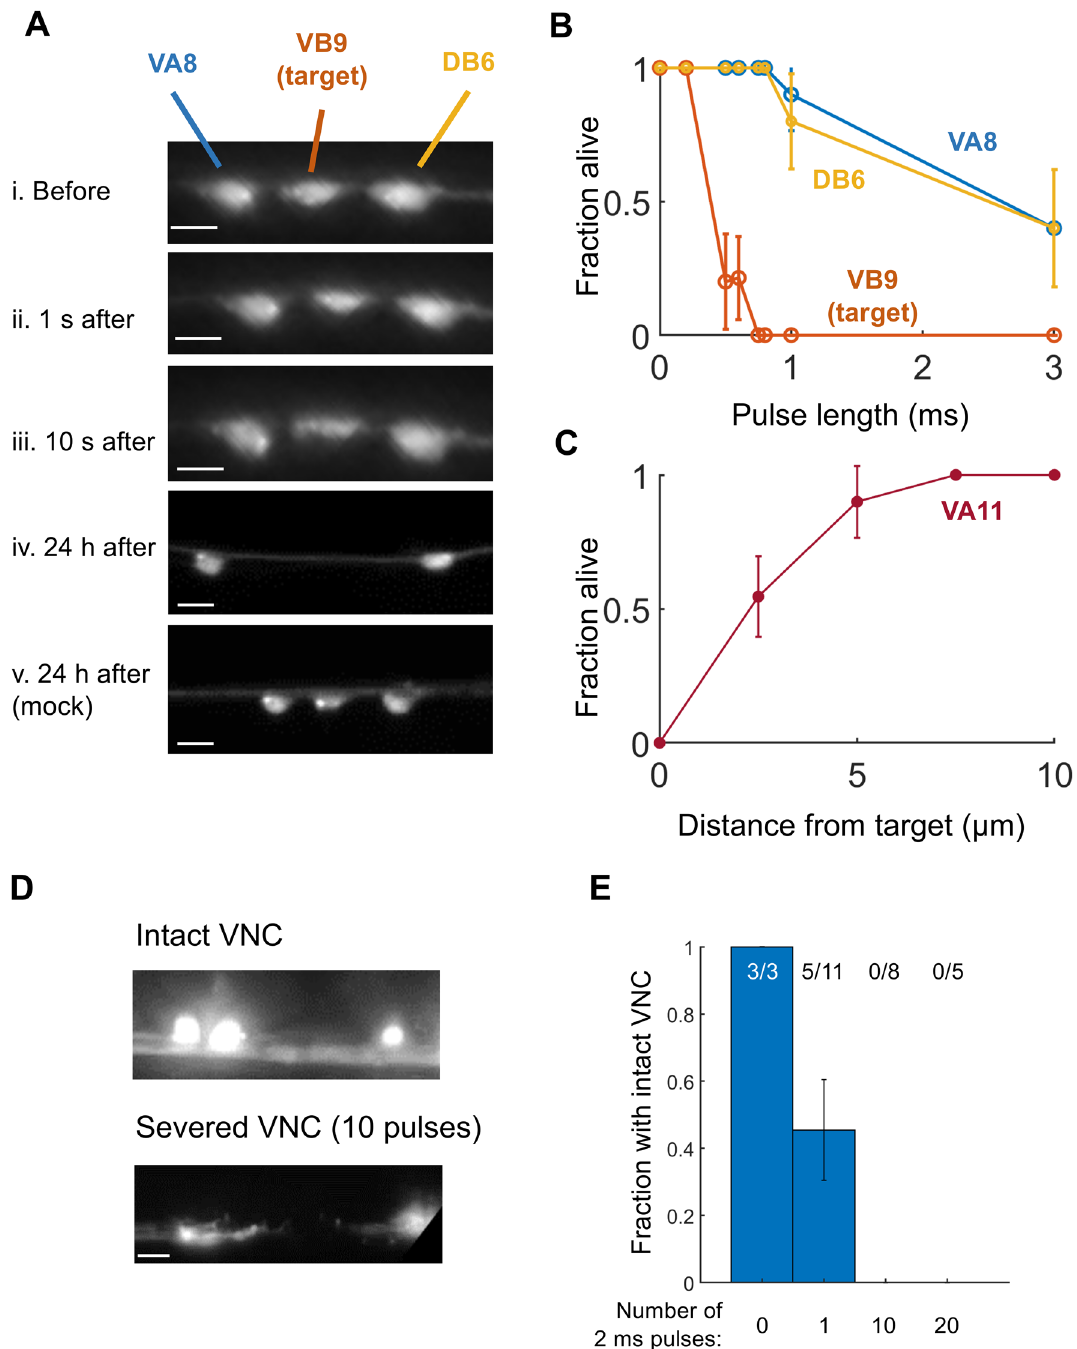
Figure 2. Lesion of specific cell bodies and nerve bundles using infrared laser surgery. ( A ) Three VNC motor neurons (VA8, VB9, DB6) immediately prior to irradiation of VB9 with a single 0.6 ms pulse (i), 1 s after irradiation (ii), 10 s after irradiation (iii), and 24 h after irradiation (iv). All scale bars are 5 μm. VA8, VB9, DB6 shown in a mock ablated animal (v). Both animals are day 1 adults. Brightness has been increased 40% in both iv and v. ( B ) Fraction of worms in which the indicated neuron was alive 24 h after irradiation of VB9 with a single pulse of the specified length. N = 5–8 worms per condition, except for the 0 ms pulse length, for which N = 2 worms. ( C ) Fraction of worms in which VA11 was alive 24 h after irradiation of the VNC at the specified distance away from the center of the VA11 cell body with a single 0.8 ms pulse. N = 5–6 worms per condition, except for 2.5 µm which had N = 11 worms. ( D ) Red fluorescence image of the ventral nerve cord shown after 0 or 10 pulses of length 2 ms were applied and the worm was allowed to recover for at least four hours. The VNC was severed after application of a train of 10 pulses. Both images are shown with brightness increased by 40%. ( E ) Fraction of worms in which the VNC was not completely severed after application of 0, 1, 10, or 20 pulses. Error bars are the standard error of the sample